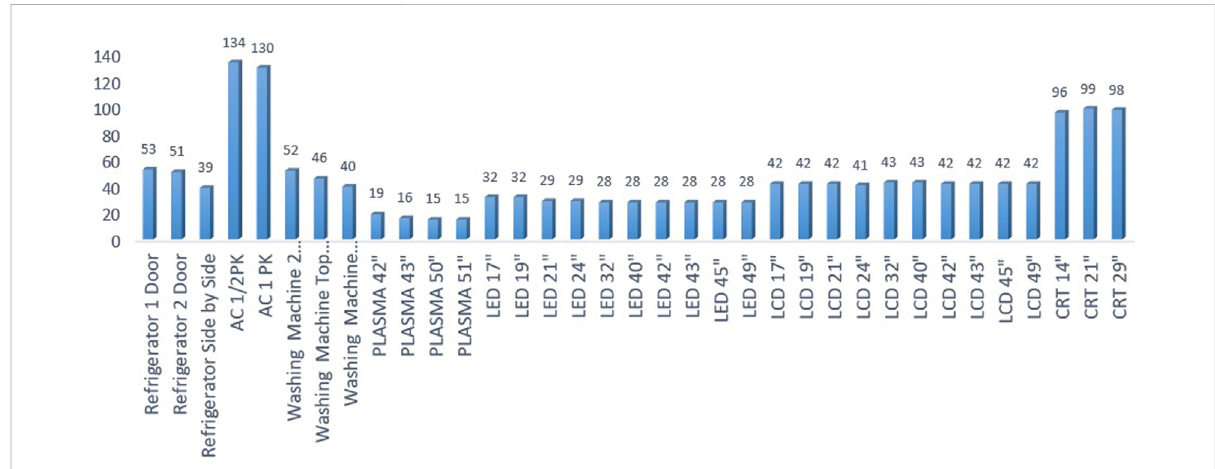
FIGURE 1 Types and quantities of electronic goods collected by the informal sector in DKI Jakarta.